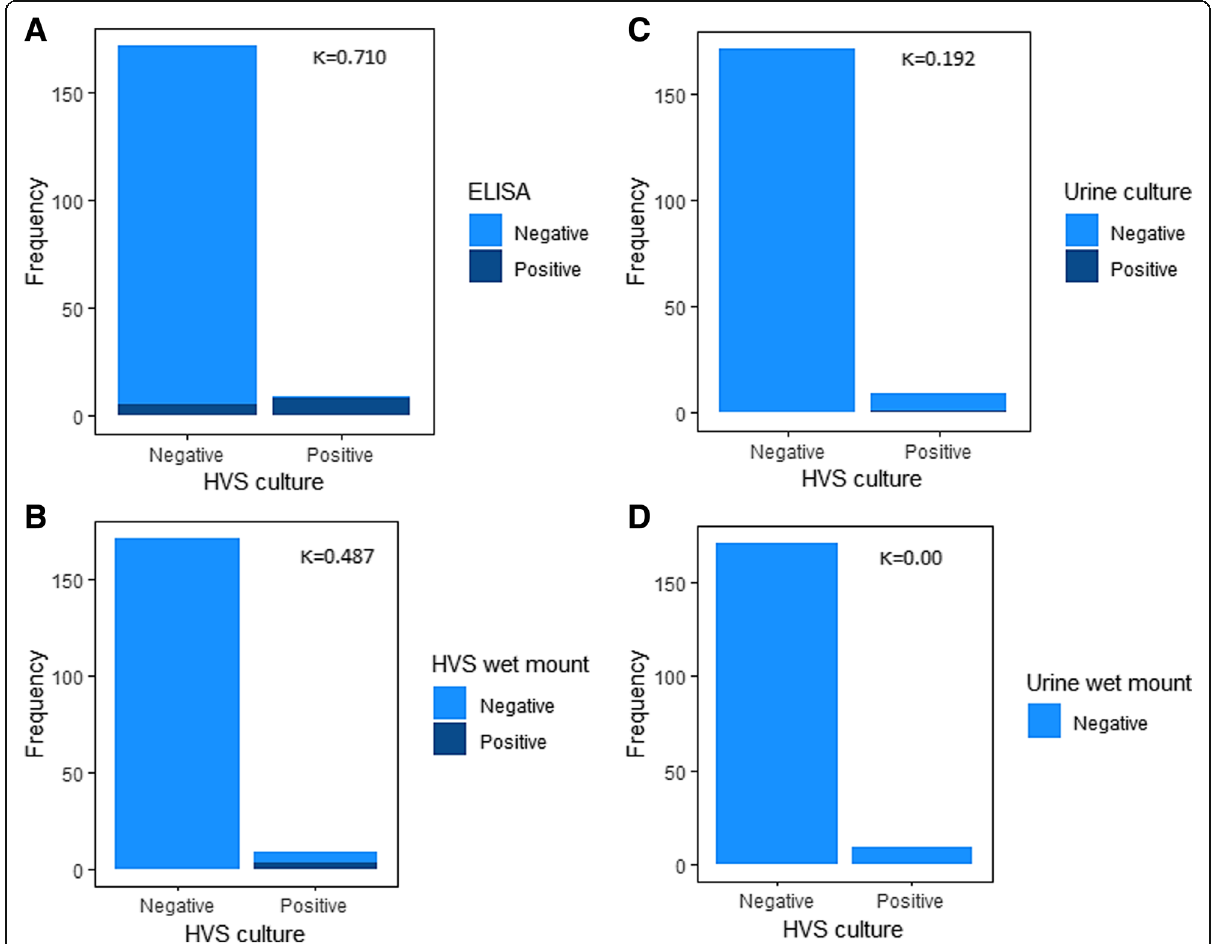
Fig. 1 Concordance evaluation between the use of HVS culture and the other